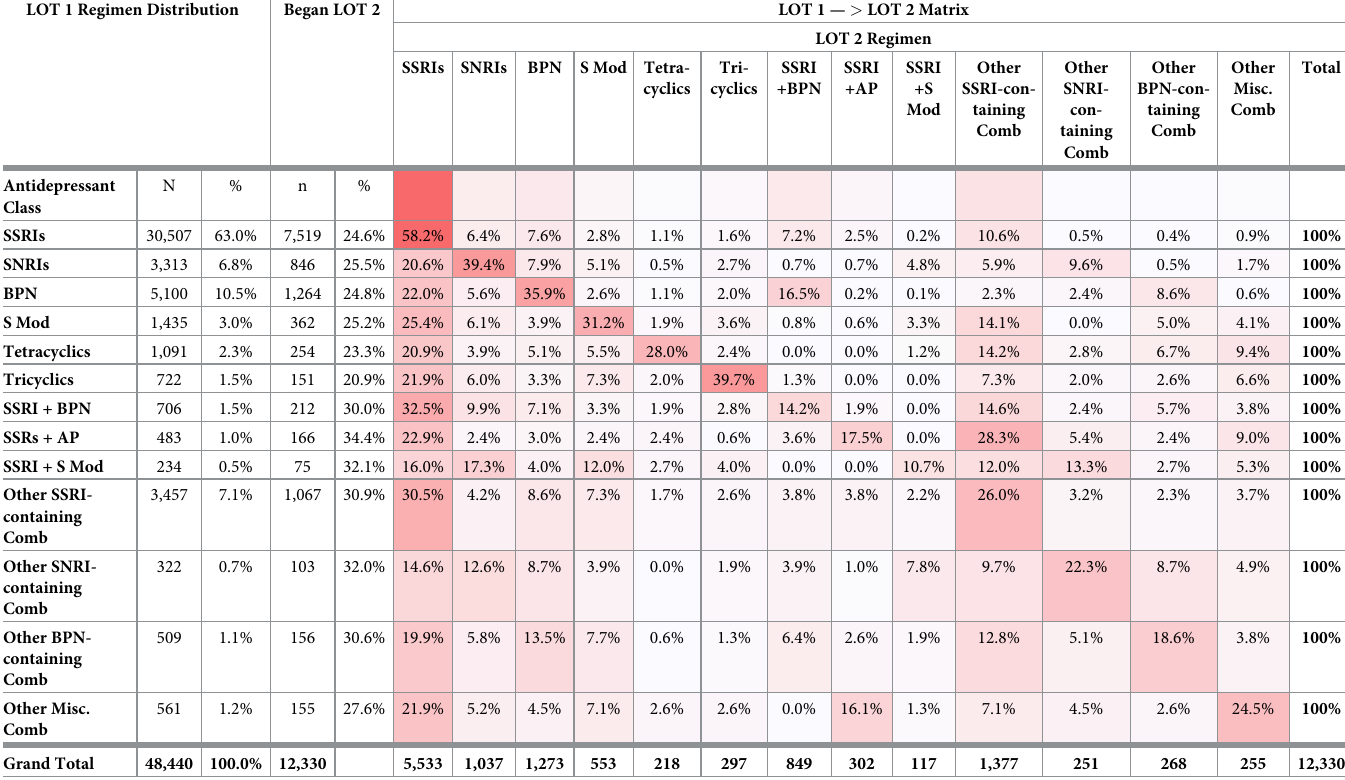
Table 1. Treatment sequence patterns from LOT1 to LOT2 during the 1 st treated MDD episode. LOT 1 Regimen Distribution Began LOT